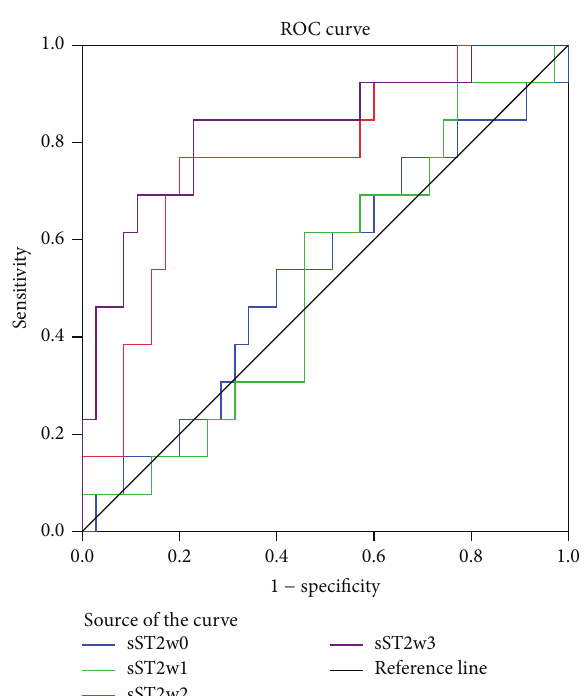
Figure 7: Receiver operating characteristic (ROC) curves to deter- mine the ability of soluble ST2 (sST2) to predict survival for patients withhepatitisBvirus-relatedacute-on-chronicliverfailure.sST2w0, sST2 at week 0; sST2w1, sST2 at week 1; sST2w2, sST2 at week 2; sST2w3, sST2 at week 3.